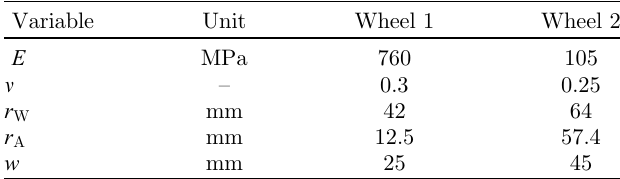
Table 3. Example wheel